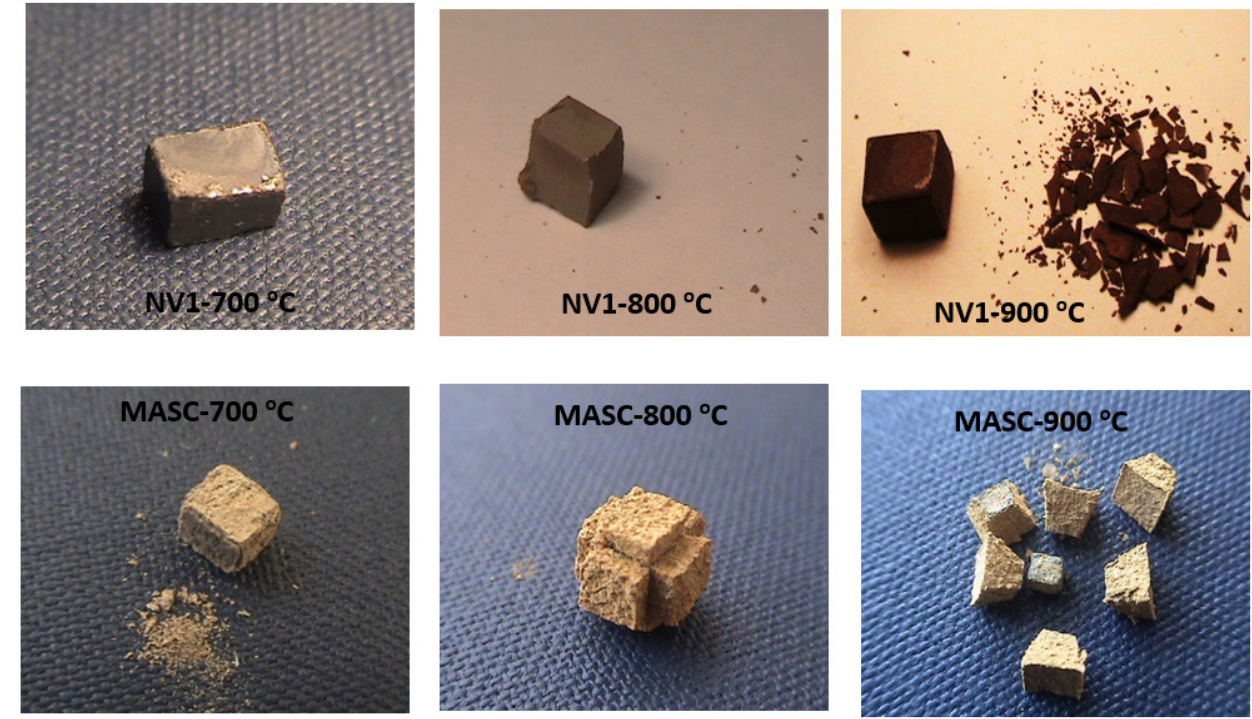
Figure 5. The oxidised specimens of the alloys NV1 (top row) and MASC (bottom row) at 700, 800, and 900 °C. The oxidised specimens of the alloy NV1 at 800 and 900 °C were studied using XRD and EPMA. The actual composition of the bulk of NV1 at 800 °C was 34.8Nb-14.9Ti-3.9Si-